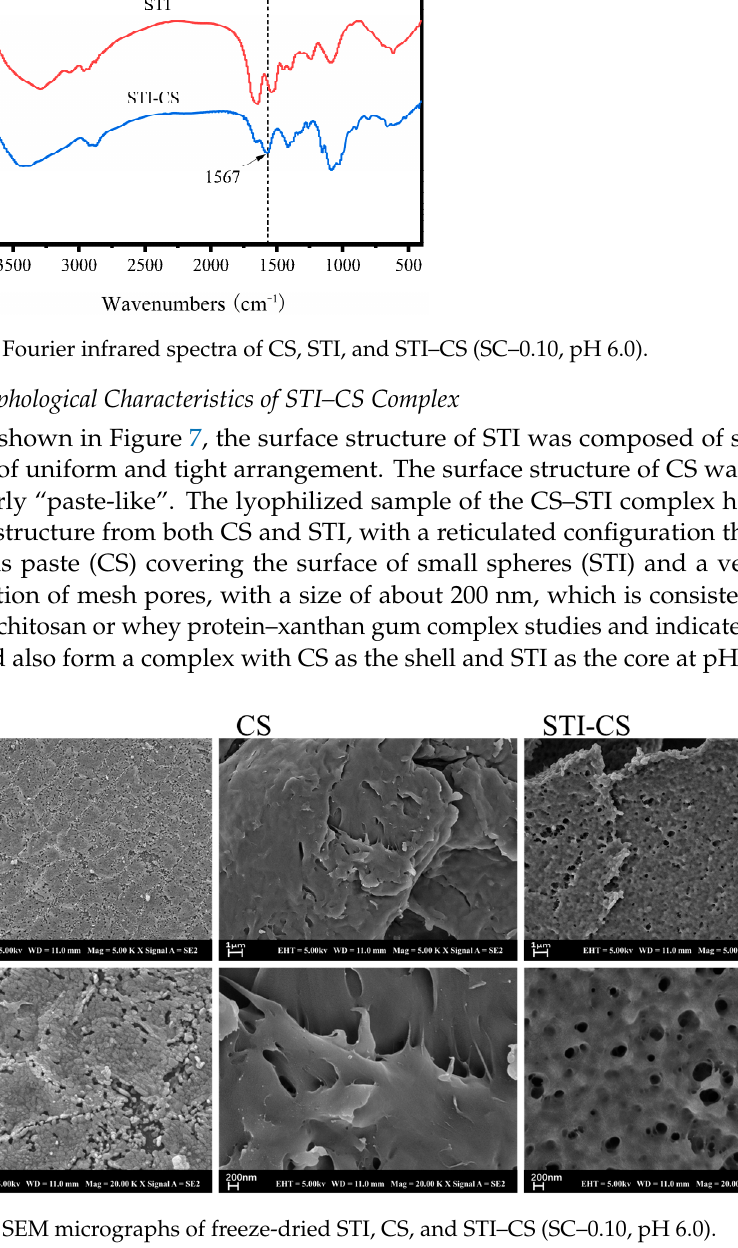
Figure 7. SEM micrographs of freeze-dried STI, CS, and STI–CS (SC–0.10, pH